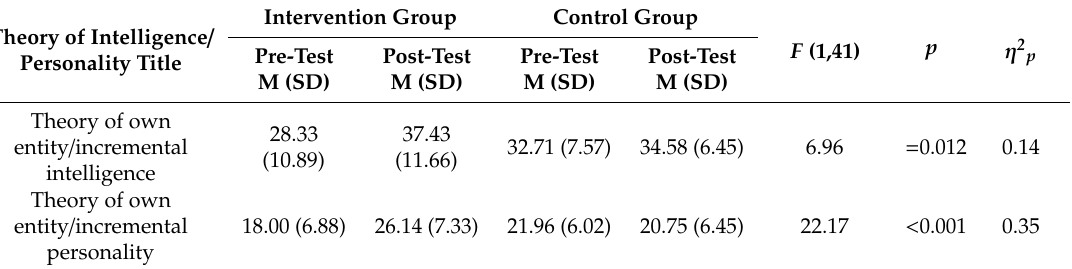
Table 6. Theory of own intelligence and personality (Questionnaire on Beliefs, QC).